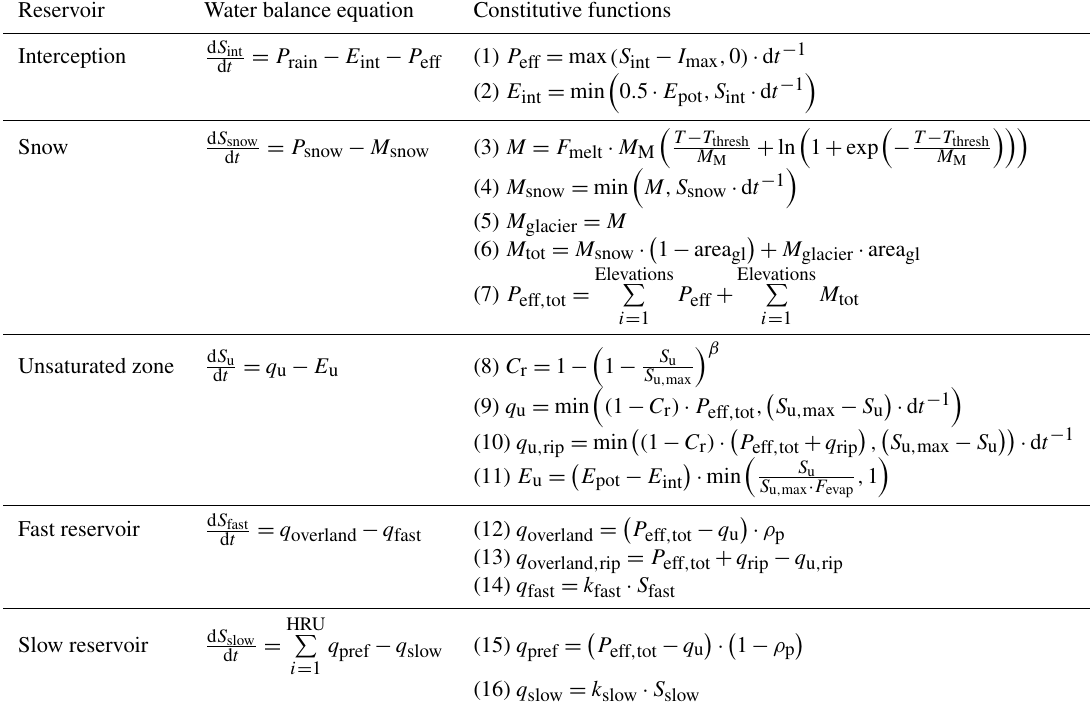
Table 3. Relevant water balance and constitutive equations of the hydrological model. Reservoirs/states (mm): S fast – fast-responding reser- voir; S glacier – glacier reservoir; S int – interception reservoir; S slow – slow-responding reservoir; S snow – snow reservoir; S u – soil reservoir. Fluxes (mmd -1 ): E int – interception evaporation; E u – evapotranspiration; M tot – melt; P – precipitation; P snow – precipitation as snow; P eff ,( tot ) – (total) effective precipitation; q base – base flow; q fast – fast runoff; q over – overland flow; q pref – preferential flow; q rip – capillary rise riparian zone. Parameters: β (–) – factor accounting for nonlinearity; F evap (–) – evapotranspiration control factor; F melt (mm ◦ C − 1 ) – melt factor; I max (mm) – max. interception capacity; k fast (d − 1 ) – fast hillslope constant; k fast , rip (d − 1 ) – fast riparian constant; k slow (d − 1 ) – slow constant; M M ( ◦ C) – smoothness parameter for melt; ρ p (–) – share preferential flow; ρ rip (–) – share riparian flow; S u , max (mm) – max. soil storage capacity; T thresh ( ◦ C) – threshold temperature for precipitation partitioning and melt; area gl – glaciated area. A detailed model description can be found in Sect.